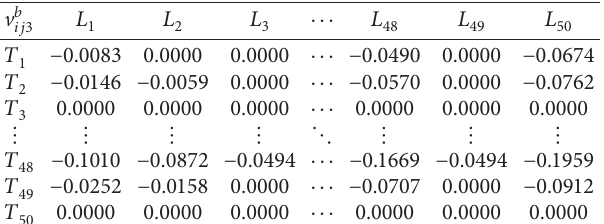
Table 31: Perceived utility matrix V b housing rent.